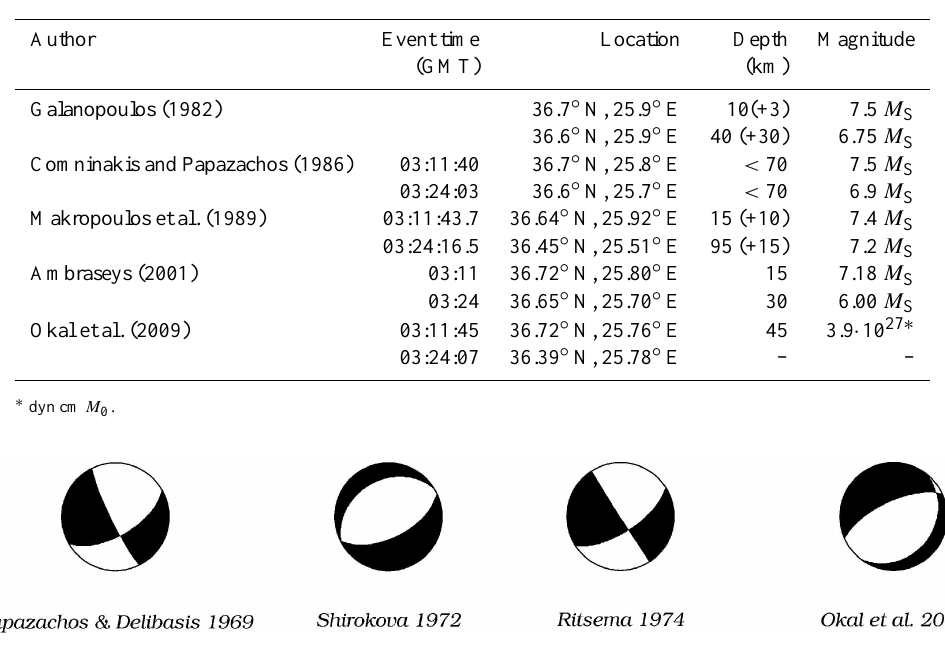
Figure 3. Fault plane solutions for the first earthquake from previous